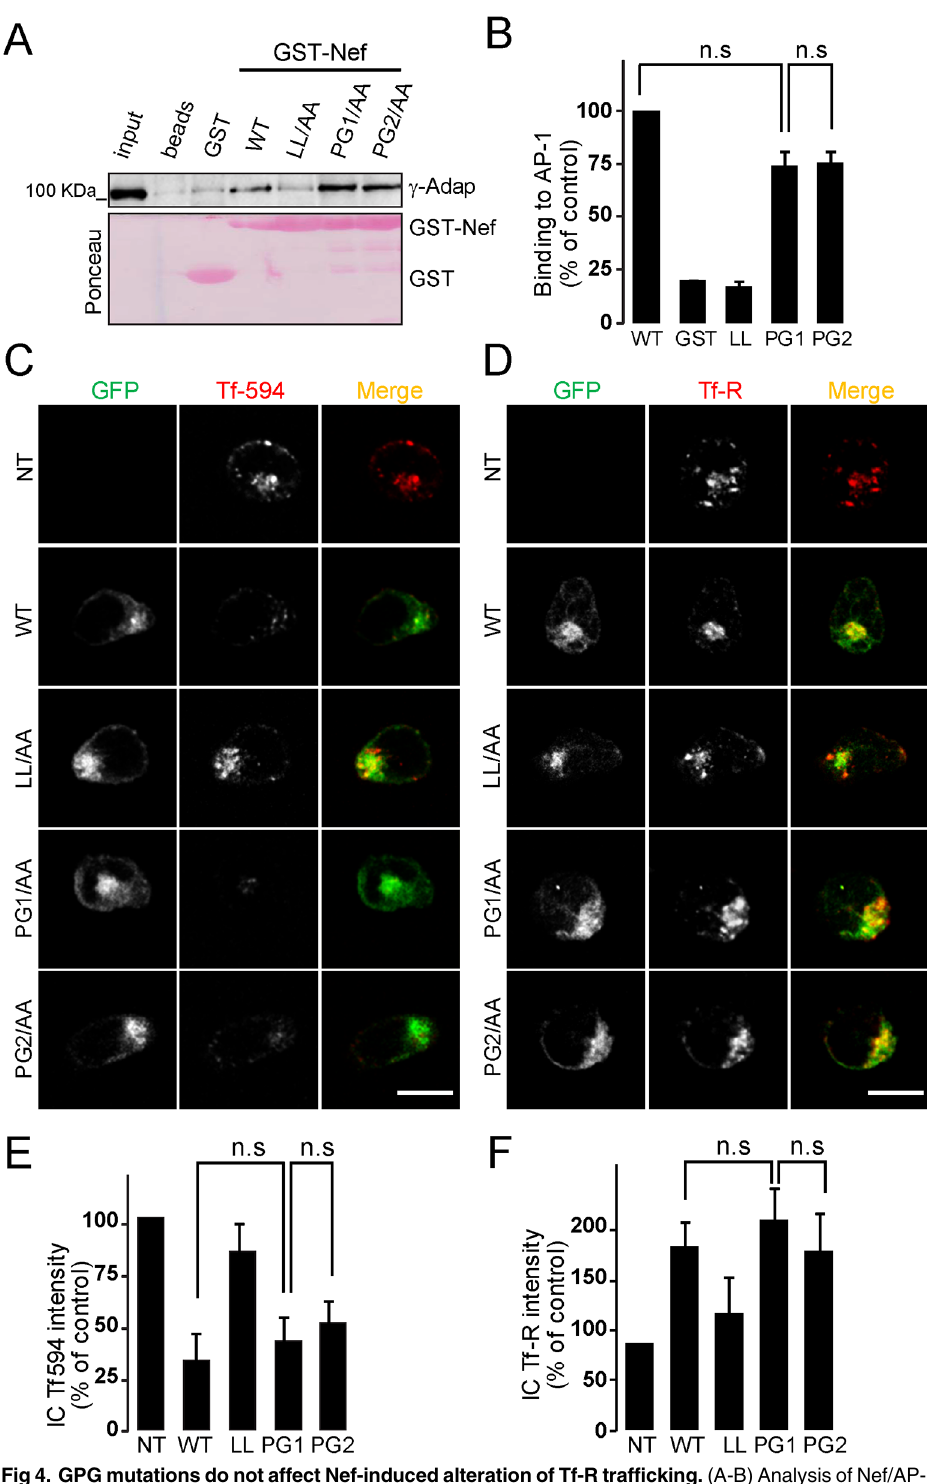
Fig 4. GPG mutations do not affect Nef-induced alteration of Tf-R trafficking. (A-B) Analysis of Nef/AP- 1interaction by i n vitro pull-down. HeLa cell lysates were incubated with equal amounts of GSH-sepharose beads, or purified GST, wild type or the indicated Nef mutants as GST-fusions previously immobilized on GSH-sepharose beads. Bound proteins were resolved by SDS-PAGE and the association of AP-1 complex was analysed by Western blotting with anti- γ -adaptin (A) and quantified by densitometry (B).